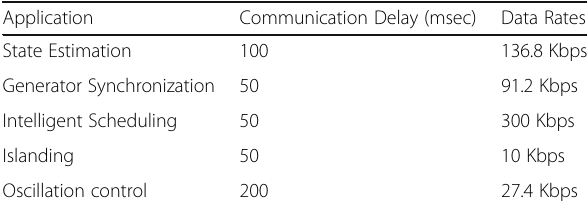
Table 4 Communication Requirements for WAMS Applications Application